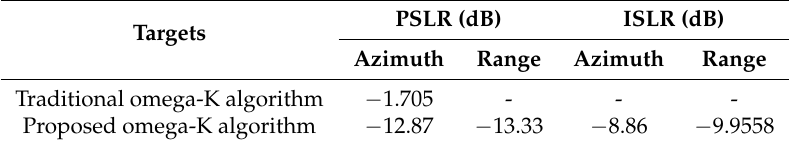
Figure 7. Azimuth impulse response of P 3 . ( a ) Traditional hyperbolic omega-K algorithm. ( b ) Proposed hyperbolic omega-K algorithm. Table 2. Image quality parameters of P 3 . PSLR, peak sidelobe ratio; ISLR, integrated sidelobe